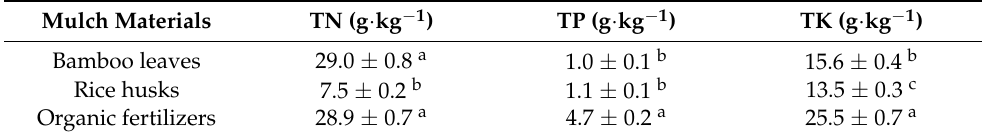
Table 2. The chemical characteristics of three mulch materials. Mulch